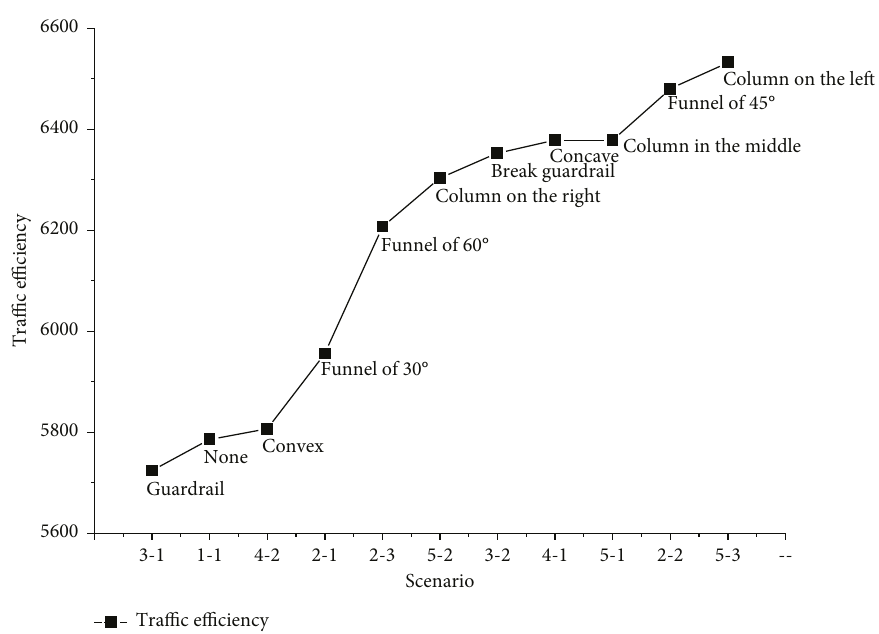
Figure 6: Traffic efficiency under different